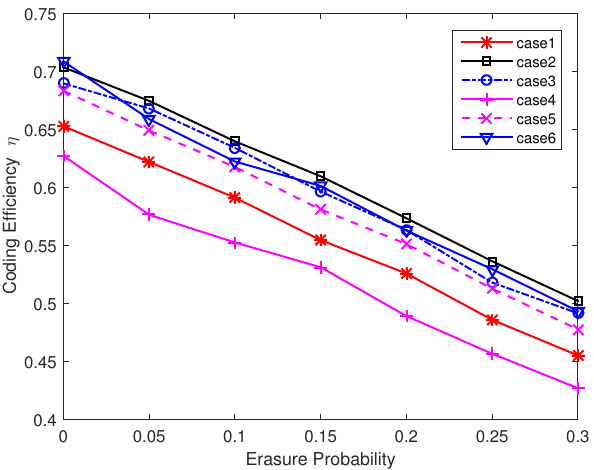
Figure 8. Coding efficiency η for different degree distribution (Three